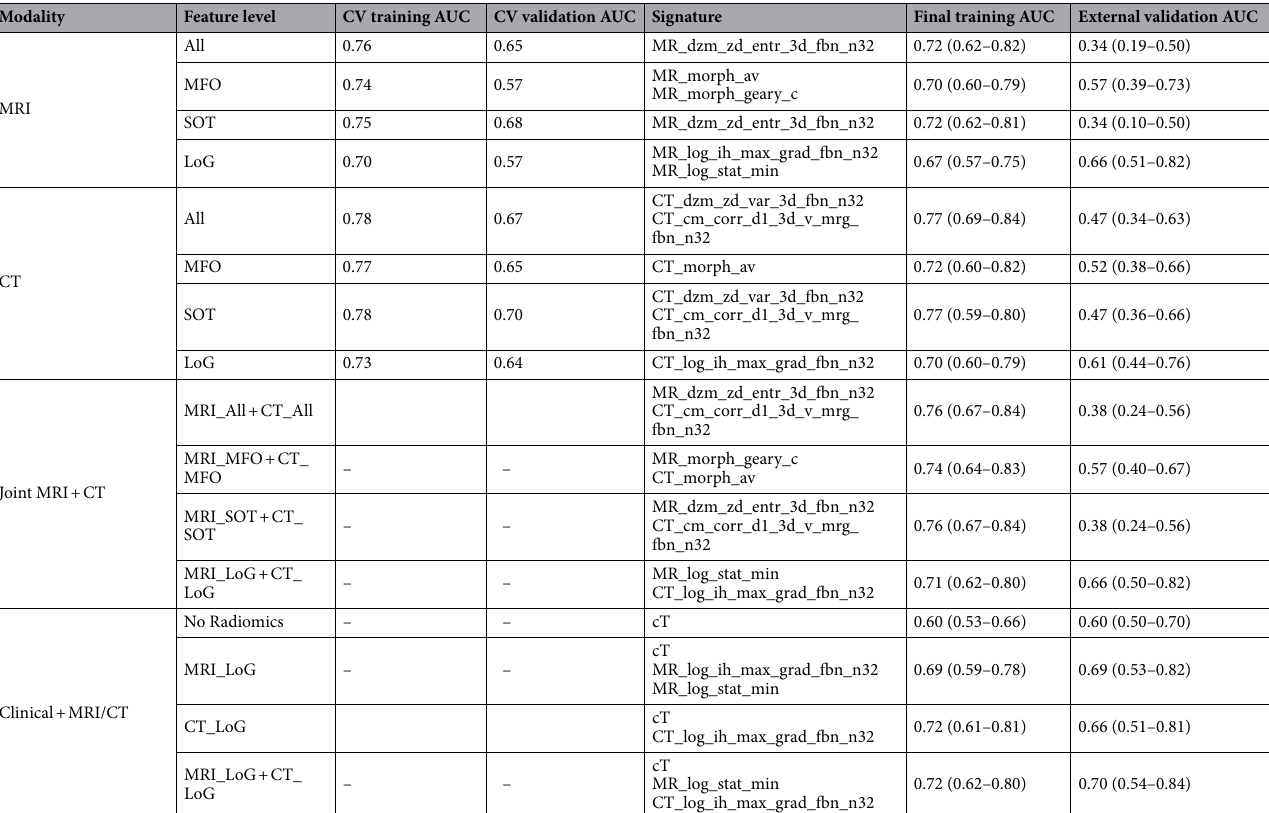
Table 2. Median area under the curve (AUC) values for cross validation (CV) and external validation for tumour response prediction based on MRI, CT, joint MRI + CT, and imaging combined with clinical T stage. Values in parenthesis represent the 95% confidence interval. AUC area under a curve, cT clinical T stage, CT computed tomography, CV cross-validation, LOG Laplacian of Gaussian, MRI magnetic resonance imaging, MFO morphological and first order, SOT second order